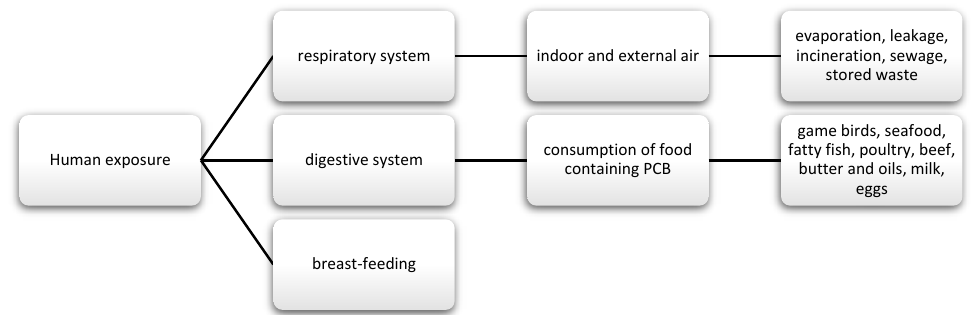
Figure 4. Main routes of exposure to polychlorinated biphenyls (PCBs).